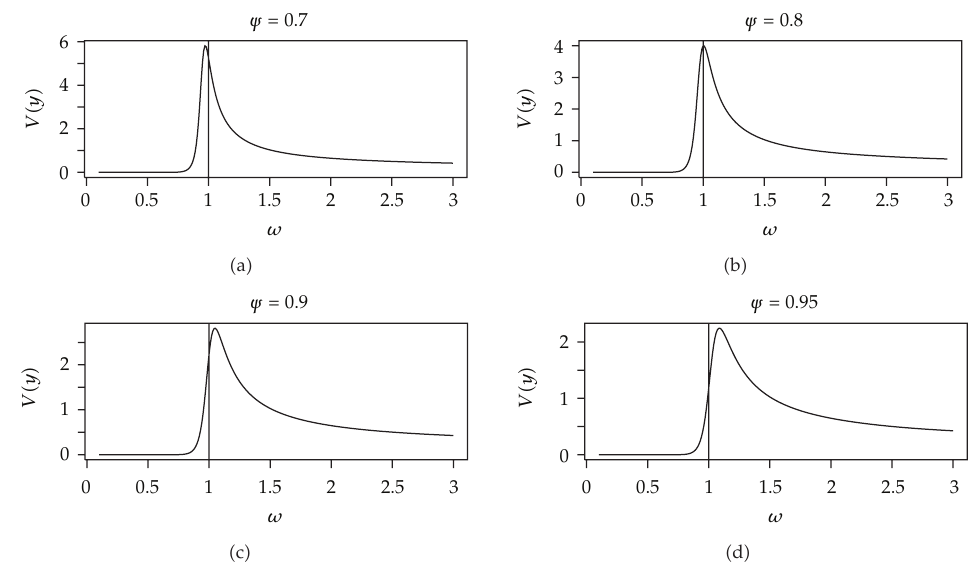
Figure 3: Variance of Y n for various values of ω at each value of ψ and n (cid:5) 25.